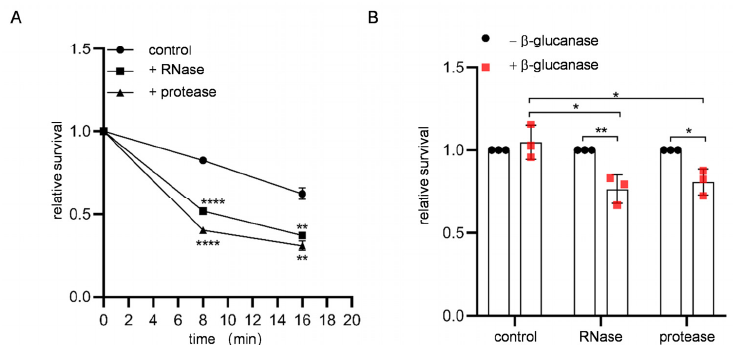
Figure 1. Stress sensitivities of spores treated with RNase or protease. ( A ) Spores treated with or without (control) RNase or protease were incubated with ether solution for the indicated times and plated on rich media, and colony numbers were counted. For each assay, the number of colonies obtained at 0 min (without ether treatment) was determined as 1, and the relative viability is shown. ( B ) Spores treated with or without (control) protease or RNase were treated with or without β -glu- canase for 2 h at 37 °C and plated on rich media, and colony numbers were counted. Data are pre- sented as the mean ± SEM. Statistical significance was determined by two-tailed unpaired Student’s t -tests. n = 3. *, p < 0.05; **, p < 0.01; ****, p < 0.0001. RNA bound to the spore wall was significantly decreased in the dityrosine layer- defective mutant dit1 ∆ [9]. Thus, the machinery to accommodate RNA is linked to the dityrosine layer. To analyze whether the dityrosine layer is compromised by protease or RNase treatments, a calcofluor white (CFW)-staining assay was performed. Because the dityrosine layer prevents the binding of CFW to chitosan in the spore wall, the integrity of the dityrosine layer can be analyzed by CFW staining [14]; for example, dit1 ∆ spores are stained by CFW (Figure 2A,B). However, the protease- or RNase-treated spores were not stained by CFW (Figure 2A,B). This result suggests that the dityrosine layer is not abrogated by these treatments. To further assess the effect of the treatments on the dityro- sine layer, the levels of dityrosine in the spores were measured. In the protease- and RNase-treated spores, dityrosine levels were decreased by 21% and 15%, respectively (Figure 2C,D). Thus, dityrosine molecules were slightly removed by protease or RNase treatment. Nevertheless, most dityrosine molecules were impervious to protease and RNase treatment.